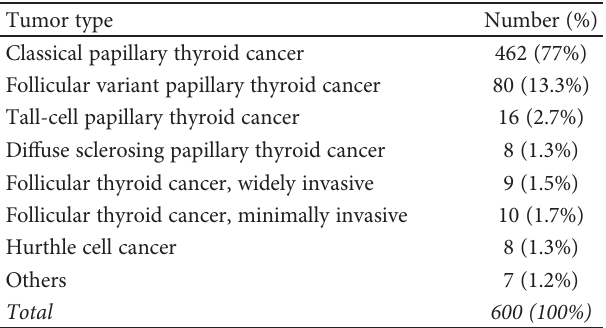
Table 2: The distribution of follicular cell-derived thyroid